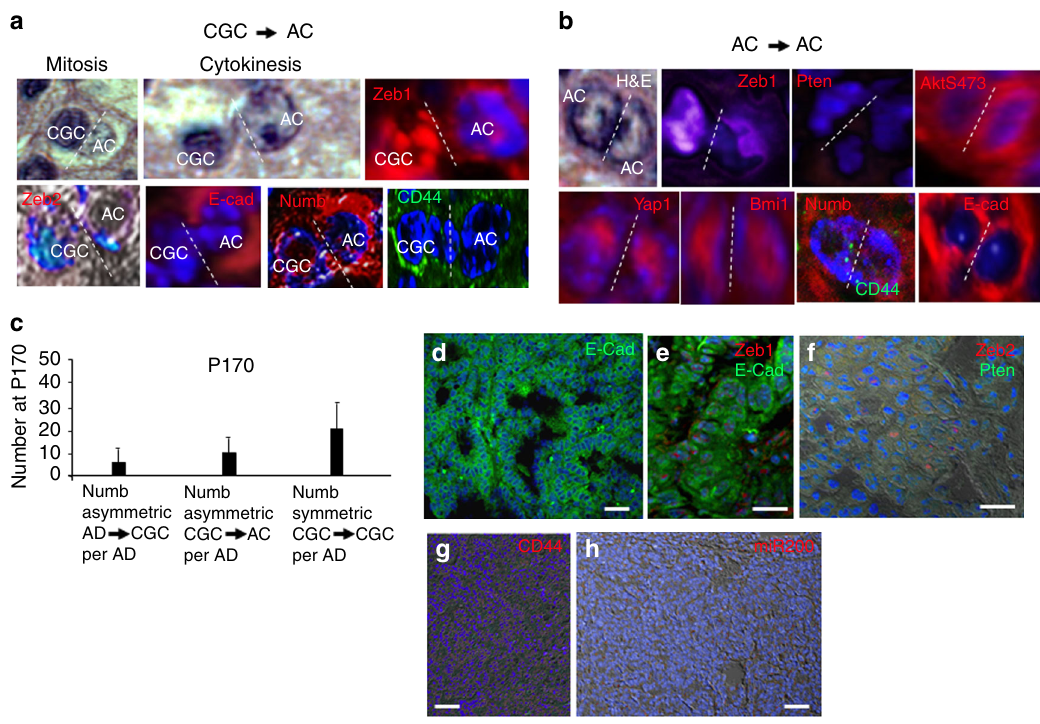
Fig. 6 IC in clusters are cancer-generating cells (CGC). a In Fig. 5g, we identi fi ed AD cells dividing to produce IC daughters. We also noted a second form of nuclear polarization in dividing cells in clusters at P170. Partially decondensed chromatin indicative of IC was evident in one pole of these cells, whereas euchromatin indicative of cancer cells was present in the opposite pole. Zeb1 was enriched in decondensed chromatin, and this pole of the cell maintained the E-cadherin- and CD44 hi pattern of IC. The opposite pole of the cell with Zeb1 lo euchromatin displayed the E-Cadherin + and CD44 lo pattern of cancer cells (AC), and Numb asymmetrically co-localized with E-cadherin. By contrast to Zeb1, Bmi1 and Yap1 were equally distributed in the